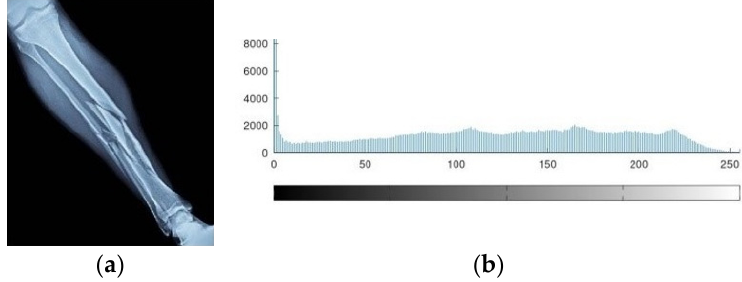
Figure 8. Input data, ( a ) Leg X-ray image, ( b ) Histogram.